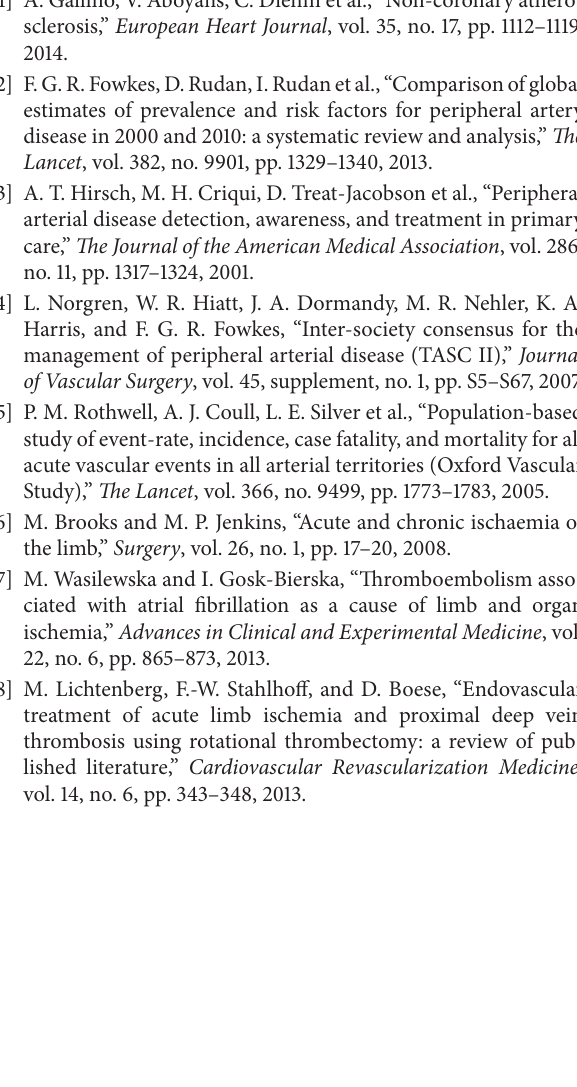
Figure 4: Triphasic flow in the SFA at 4 weeks of follow-up.